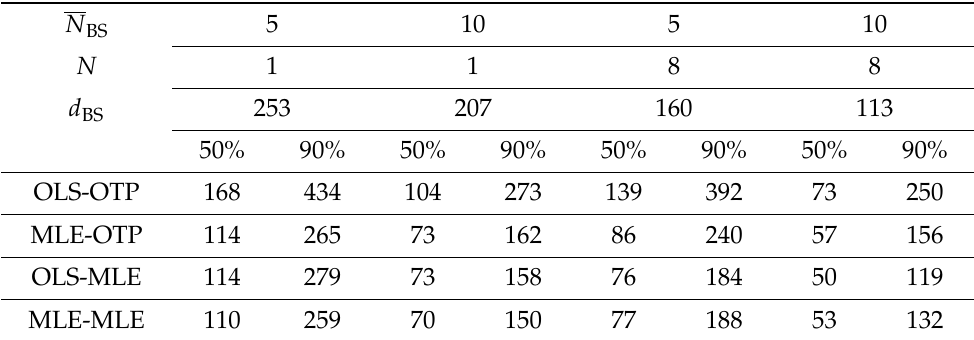
Table 7. Positioning error, in meters, 50th and 90th percentiles of Example 3 (2 GHz). Base stations have omnidirectional ( N = 1) or directional antennas ( N = 8) and the average number of contacted BSs is N BS = 5 or 10.